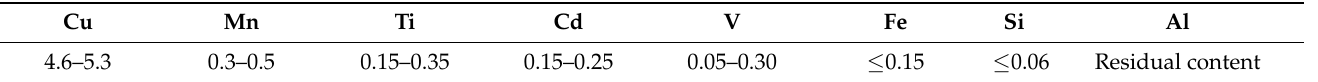
Table 1. Chemical composition of the ZL205 alloy